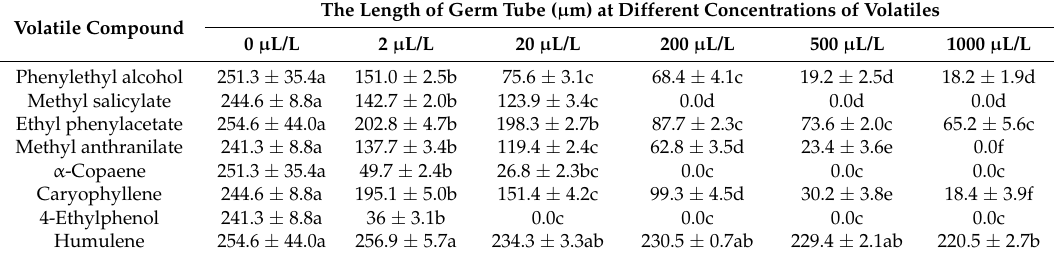
Table 8. Effect of volatile compounds on P. litchii germ tube